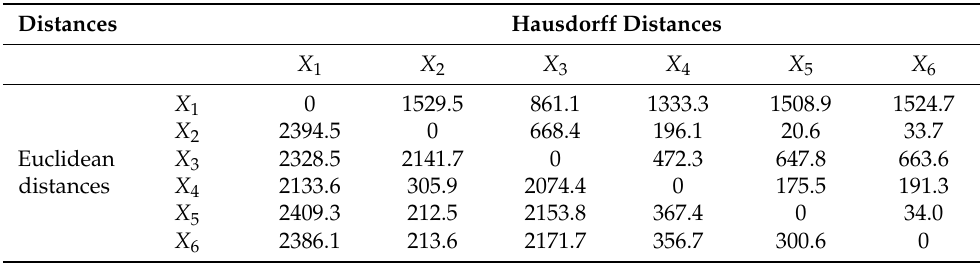
Table 9. Hausdorff and Euclidean distances between feature vectors of the years under study: 2015 ( X 1 ), . . ., 2020 ( X 6